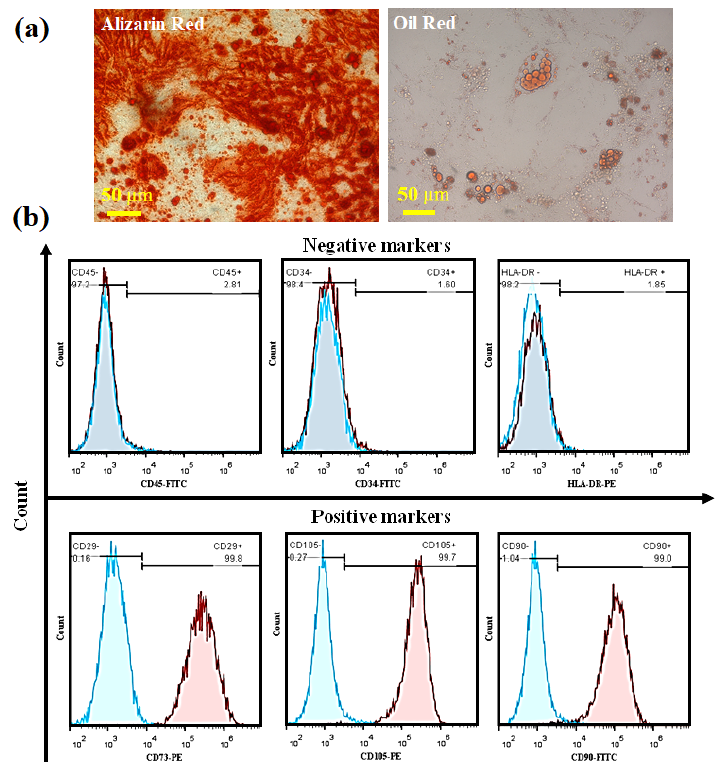
Figure 8. ( a ) Differentiation potential of stem cells after 21 days toward osteogenic (Alizarin Red) and adipogenic lineages (Oil Red) and ( b ) Histograms of distribution of CD29+, CD34+, CD45+, CD90+, CD105+, and HLADR+ after 21 days incubation.